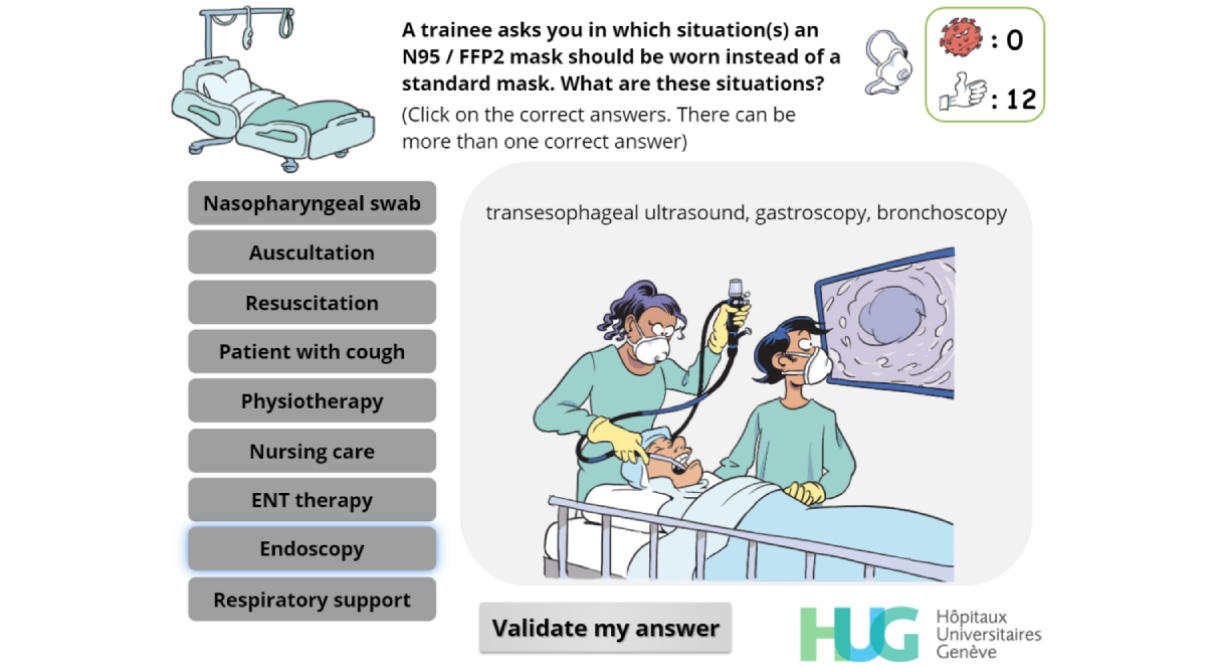
Figure 7. Multiple-choice interaction. The player must choose in which situations N95 masks should be worn. Illustrations change as the cursor hovers over the buttons on the